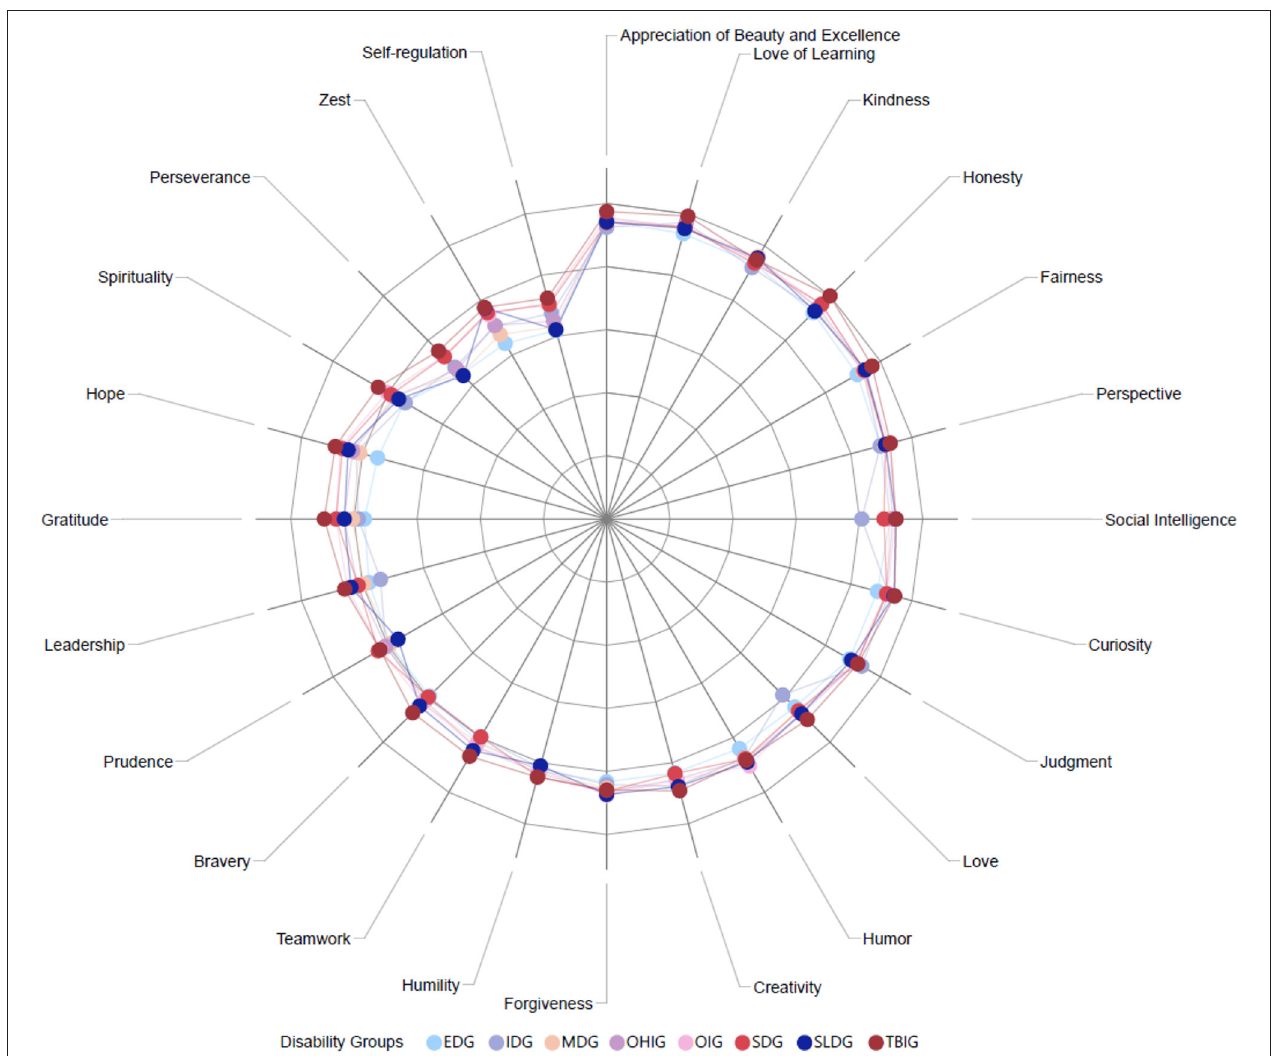
FIGURE 3 | Radar chart for disability groups by character strengths. TBI, Traumatic brain injury; OI, Orthopedic impairment; SD, Sensory disabilities; SLD, Speech-language disabilities; OHI, Other health impairments; MD, multiple disabilities; IDD, Intellectual disabilities; ED, Emotional